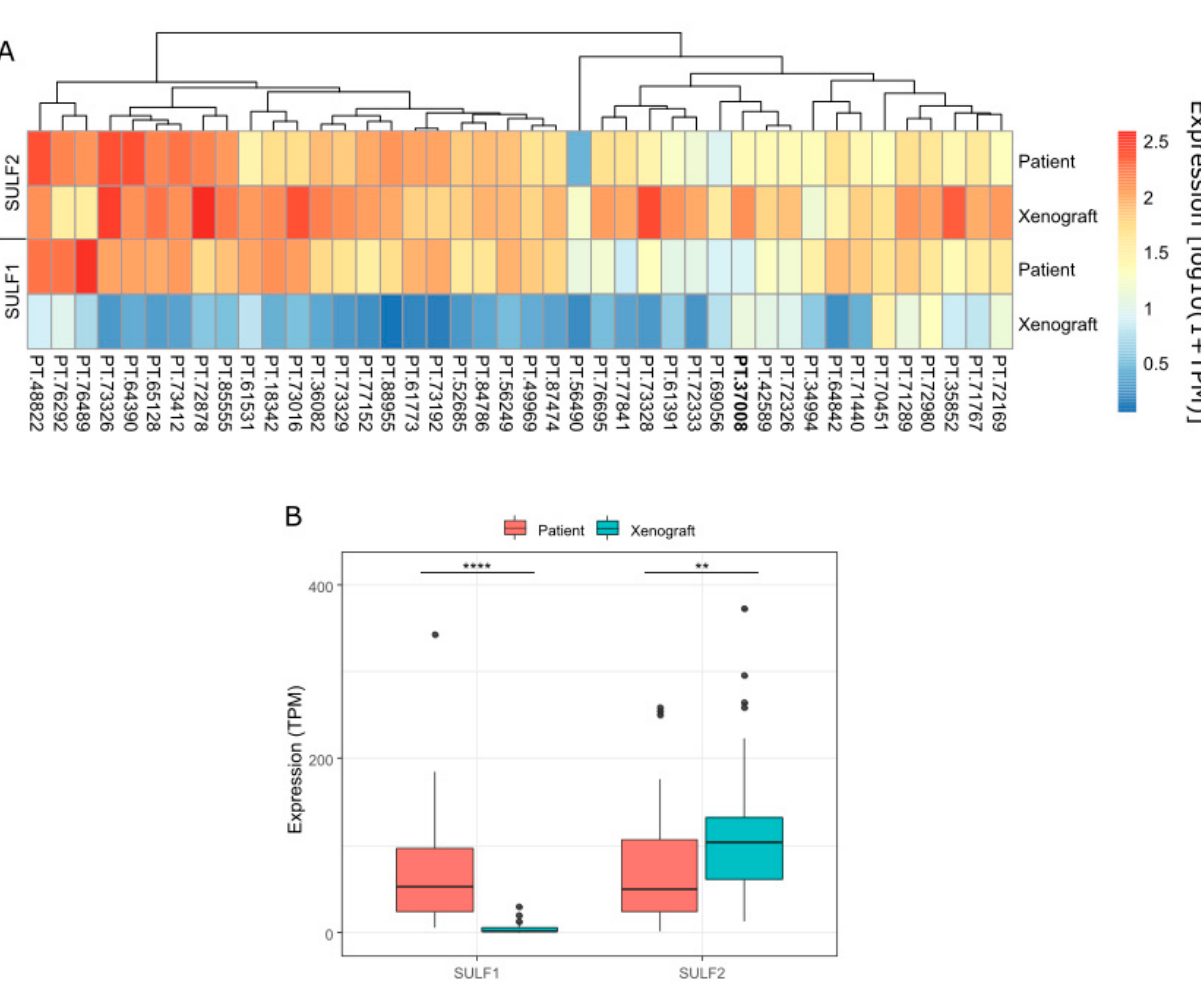
Figure 5. Comparison of RNA expression of SULF1 and SULF2 in primary HNSC tumors (n = 42) and their PDX in immunocompromised mice: ( A ) heatmap of log10(1+TPM) expression of SULF1 and SULF2. Patient ID in bold represents the one case in which SULF1 expression does not decrease from patient to PDX; ( B ) boxplots of SULF1 and SULF2 expression (TPM) in Patient and PDX samples (** p < 0.01, **** p < 1 × 10 − 4 ; Wilcoxon rank-sum test).